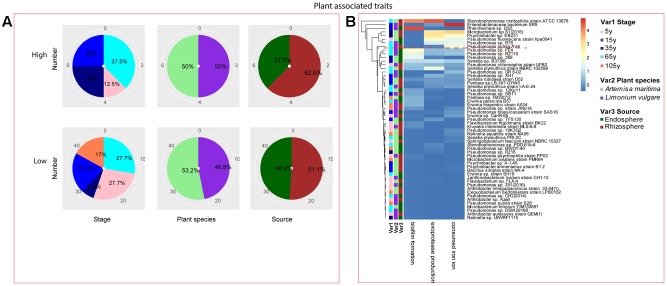
Distribution of plant growth promoting traits of root-associated bacterial strains. (A) Distribution of isolates from different treatments according to high and low growth profiles in plant growth promoting traits (biofilm formation, production of exoprotease and siderophore). (B) Heatmap profiles for plant growth promoting traits of all isolates. The annotation of treatments – successional stages, plant species and plant compartments and corresponding colors are the same with those in Figure 4. The blue-red gradient bar represents the normalized absorbance values (Z-scores). Only the integer scaled values (0–4) were shown alongside the color bar. The red dashed line separates the high and low bacterial functional profiles, which were determined by the cluster assignment based on the average Euclidean distance among the bacterial strains.